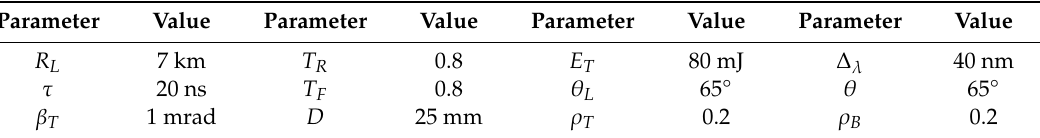
Table 2. Typical working conditions of semi-active laser guidance